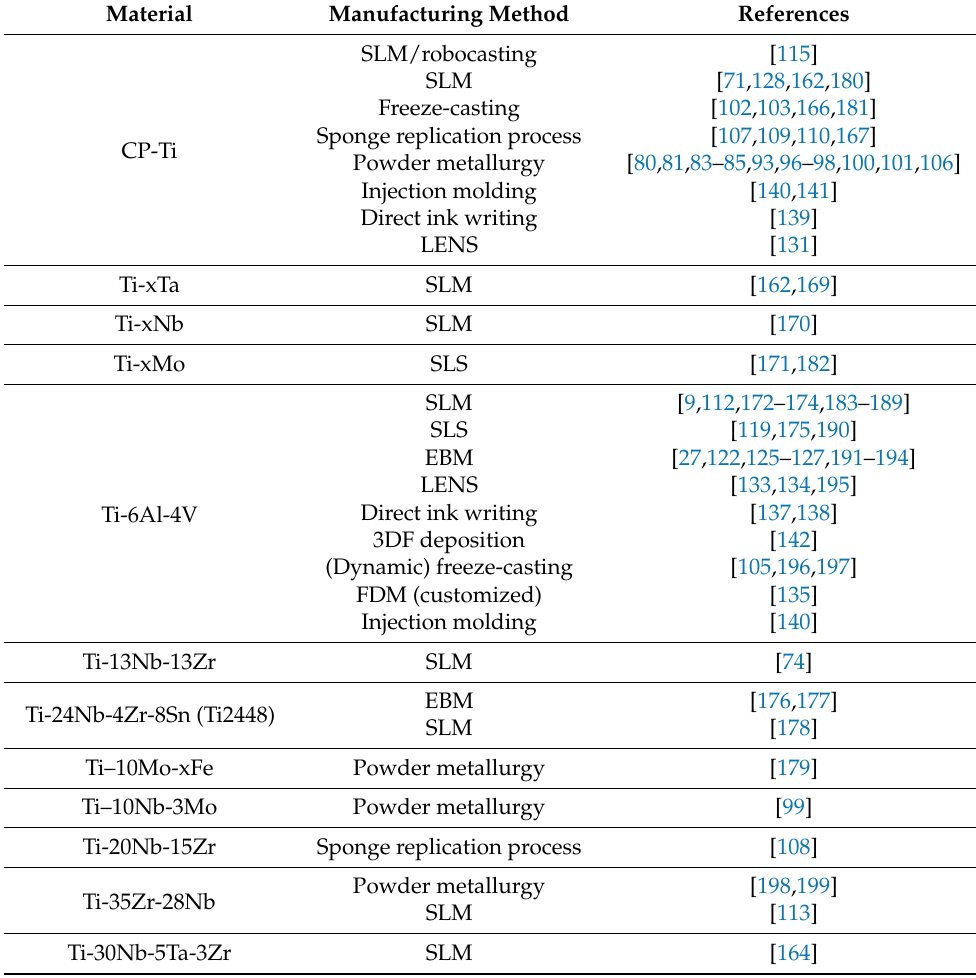
Table 5. Materials applied for scaffolds together with fabrication